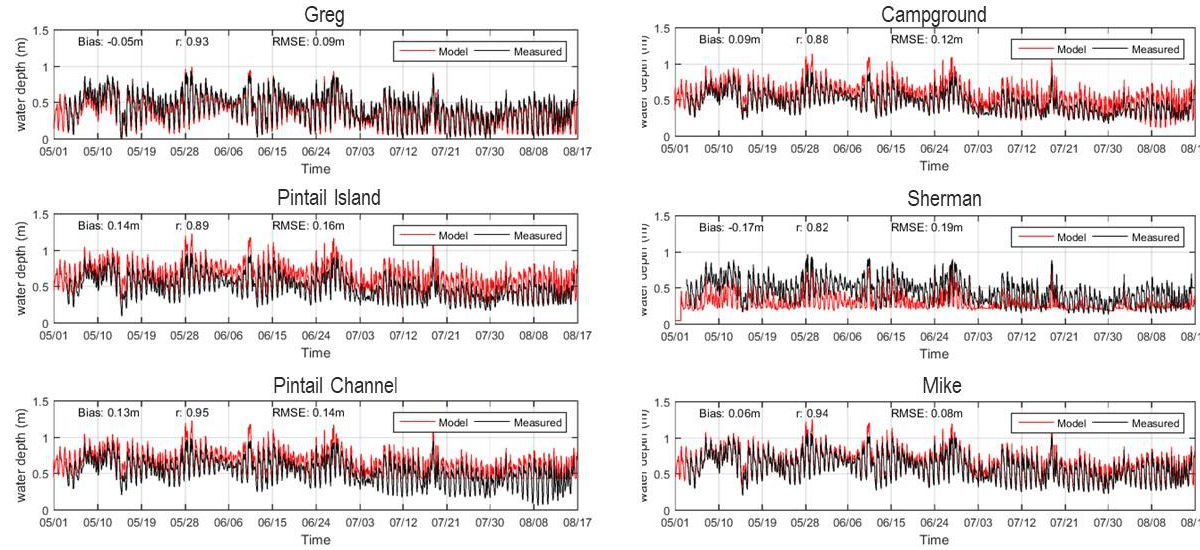
Figure A2. Comparison of modeled and measured water level within the Wax Lake Delta—see Figure A1 for locations.